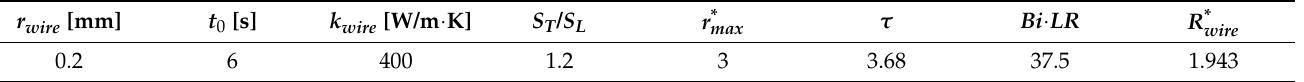
Table 2. Geometrical and operating parameters for baseline test-case of single PCM-wire model.